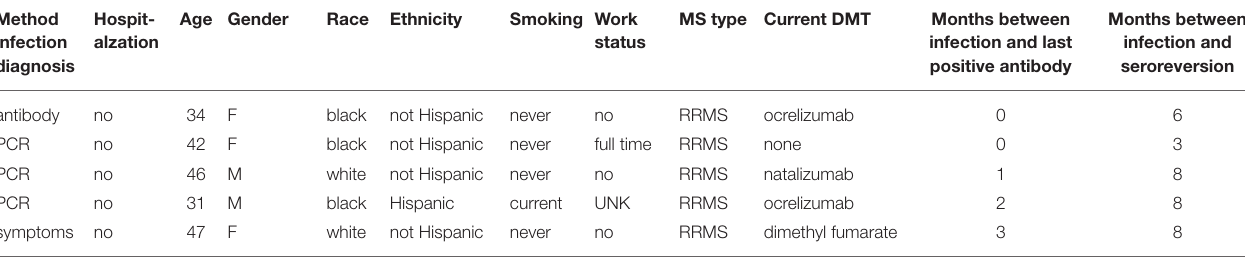
TABLE 4 | Characteristics of patients who converted from seropositive to seronegative. Method